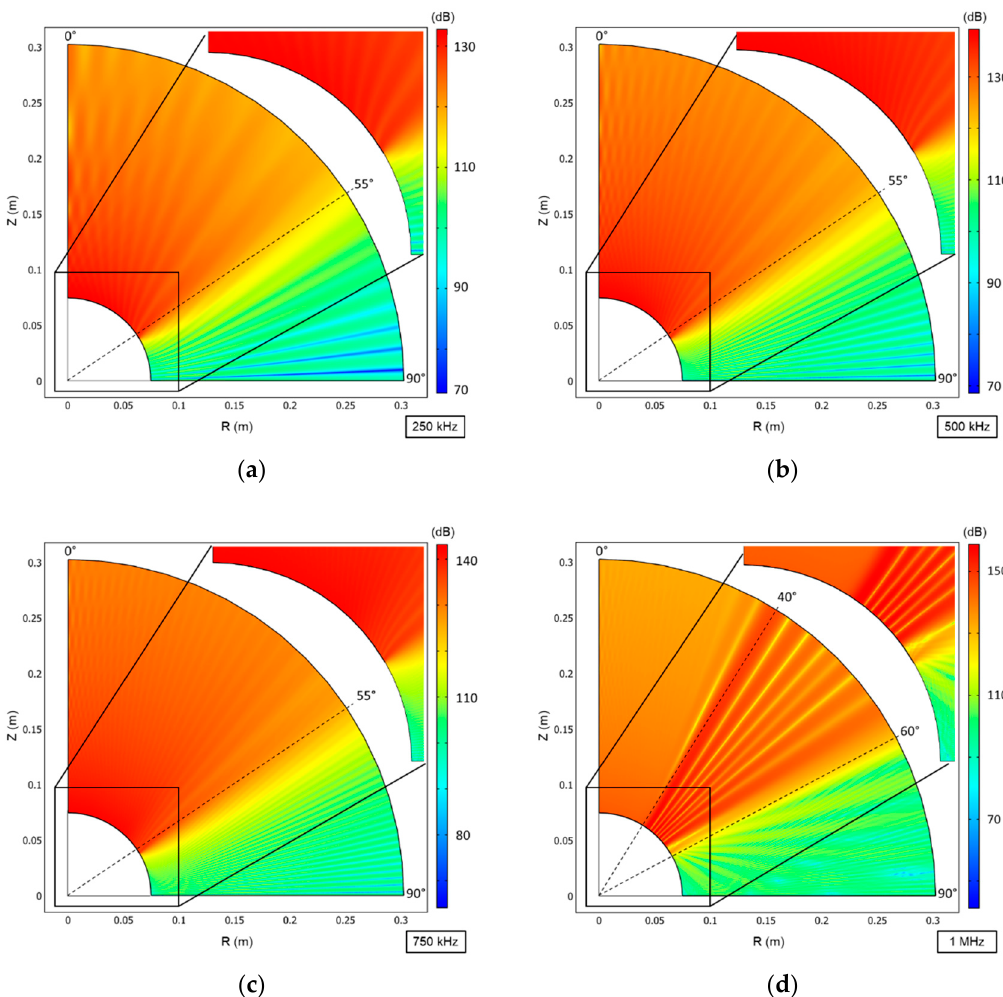
Figure 3. Sound Pressure Level (dB re 1 µPa) simulation results in a symmetrical axis for: ( a ) 250 kHz; ( b ) 500 kHz; ( c ) 750 kHz; ( d ) 1 MHz. The max responsive axis with a maximum deviation of 6 dB is marked by the dashed line.